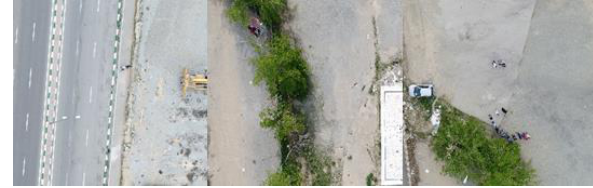
Figure 5. Some examples of Drone images